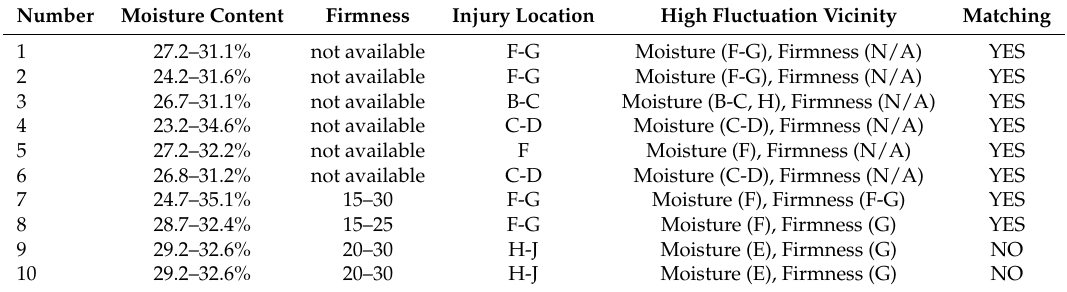
Table 3. Injury location, surface condition range and the zones on the track with of high